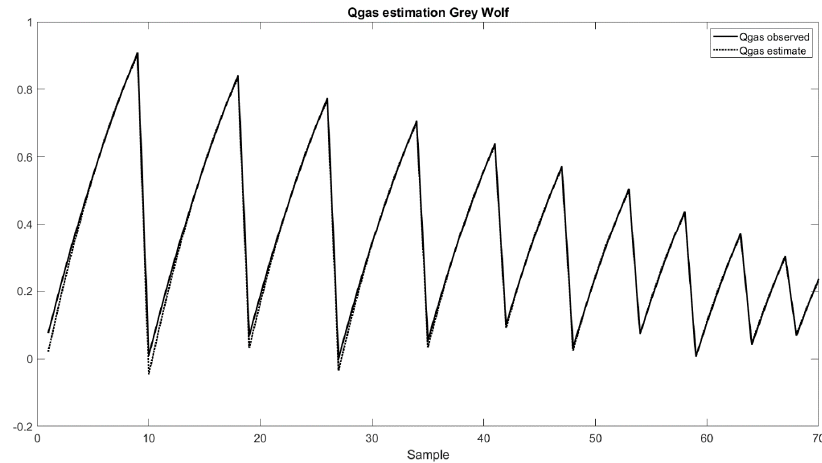
Figure 9. Example of observed and estimated variable tracking with Grey Wolf Algorithm.